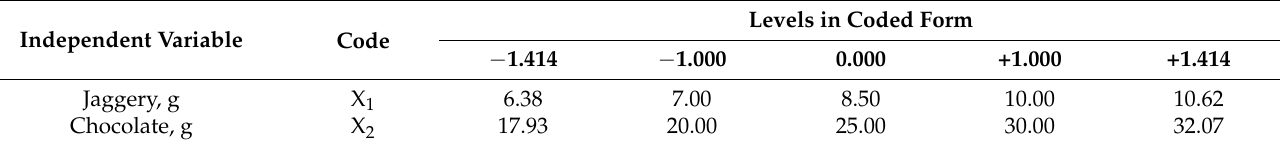
Table 1. Central composite rotatable design in coded and uncoded forms of independent variables. Levels in Coded Form Independent Variable Code − 1.414 − 1.000 Jaggery, g X 1 Chocolate, g X